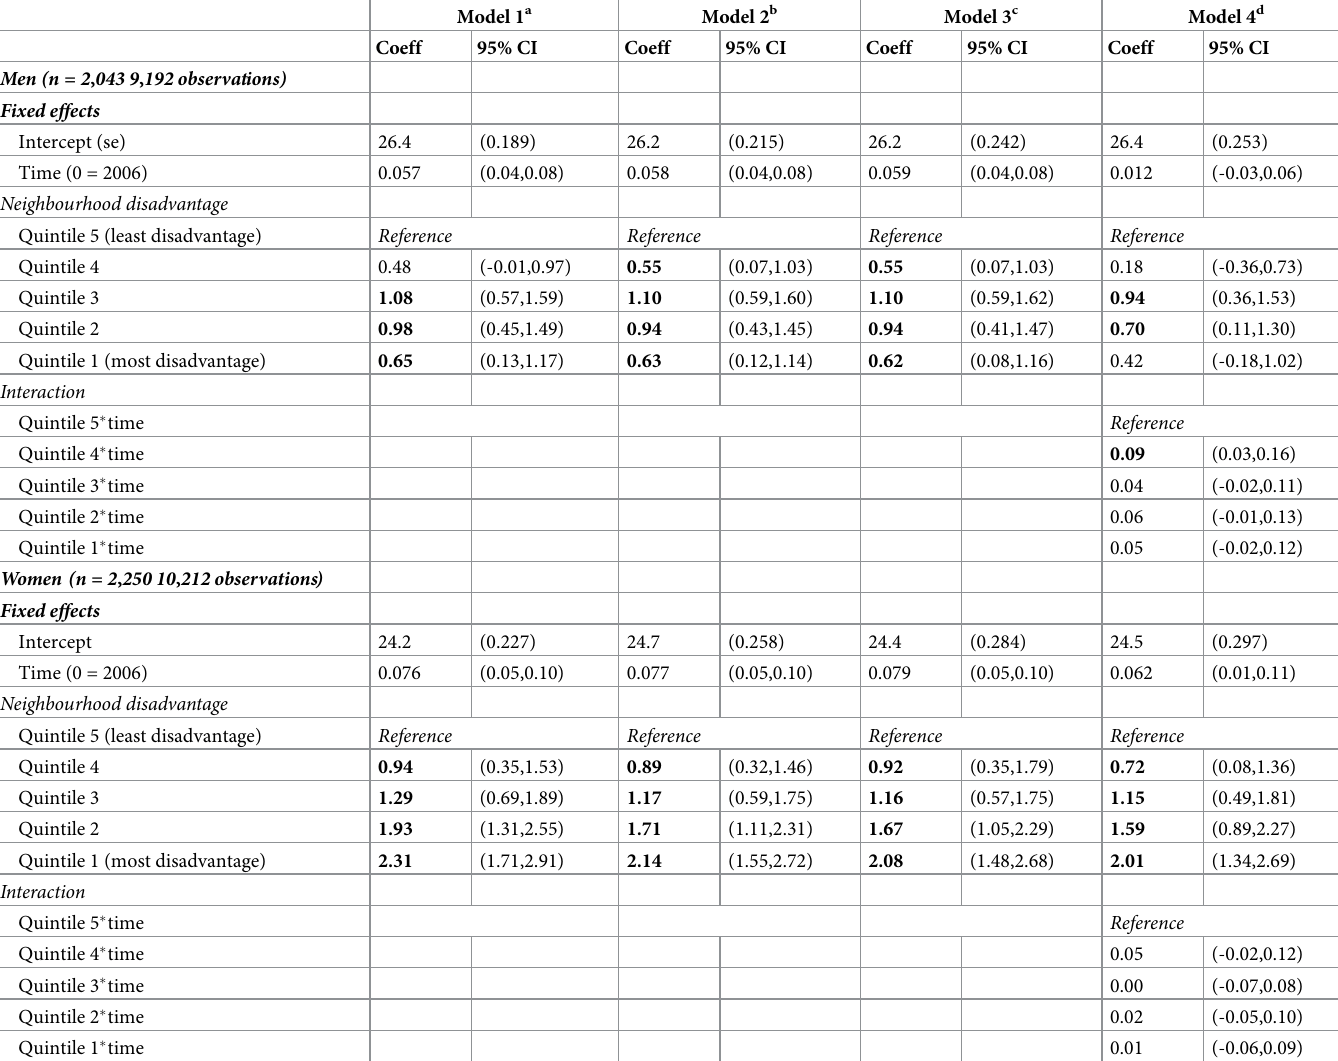
Table 2. Neighbourhood disadvantage and BMI for immigrant men and women,